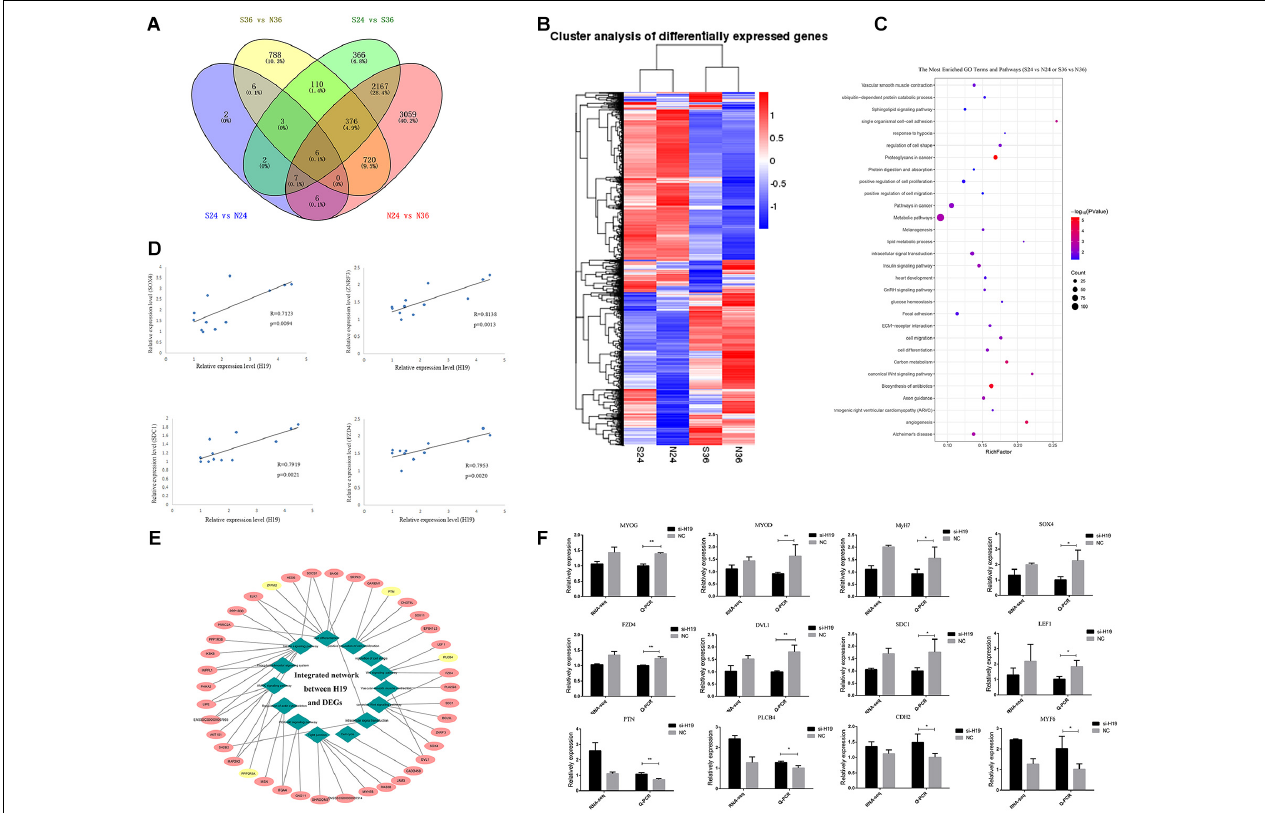
FIGURE 3 | The analyses of DEGs. (A) Venn diagrams of the DEGs in different comparisons. (B) Hierarchical clustering dendrogram analyses were conducted with 7617 overlapped DEGs among four different comparative groups (S24 versus N24, S36 versus N36, N24 versus N36, S24 versus S36). Each column represents a sample, and each row represents a DEG. The colors correspond to a normalized expression value of each transcript (red: high relative expression; blue: low relative expression). (C) The most enriched top 30 GO terms and KEGG pathways. Columns from bottom to top represent P -values from small to large. (D) Linear regression of H19 and selected DEG expression. The R and P indicate the Pearson correlation coefficient and p value of each pair of H19 and DEGs in 12 samples (three for si24, three for NC24, three for si36, three for NC36). (E) Integrated network analysis of H19 and selected DEGs. Green rhombus represents different GO terms and pathways, similar processes are classified into one category, and 14 major categories exist. Pink and yellow ellipses represent positive and negative regulation between H19 and DEGs, respectively. (F) Verification of sequencing data by Q-PCR. Comparisons of relative expression levels for 12 DEGs. Comparisons of relative FPKM in the left; comparisons of relative expression levels in the right. Mean values ± SEM, n = 3. * p < 0.05, ** p <